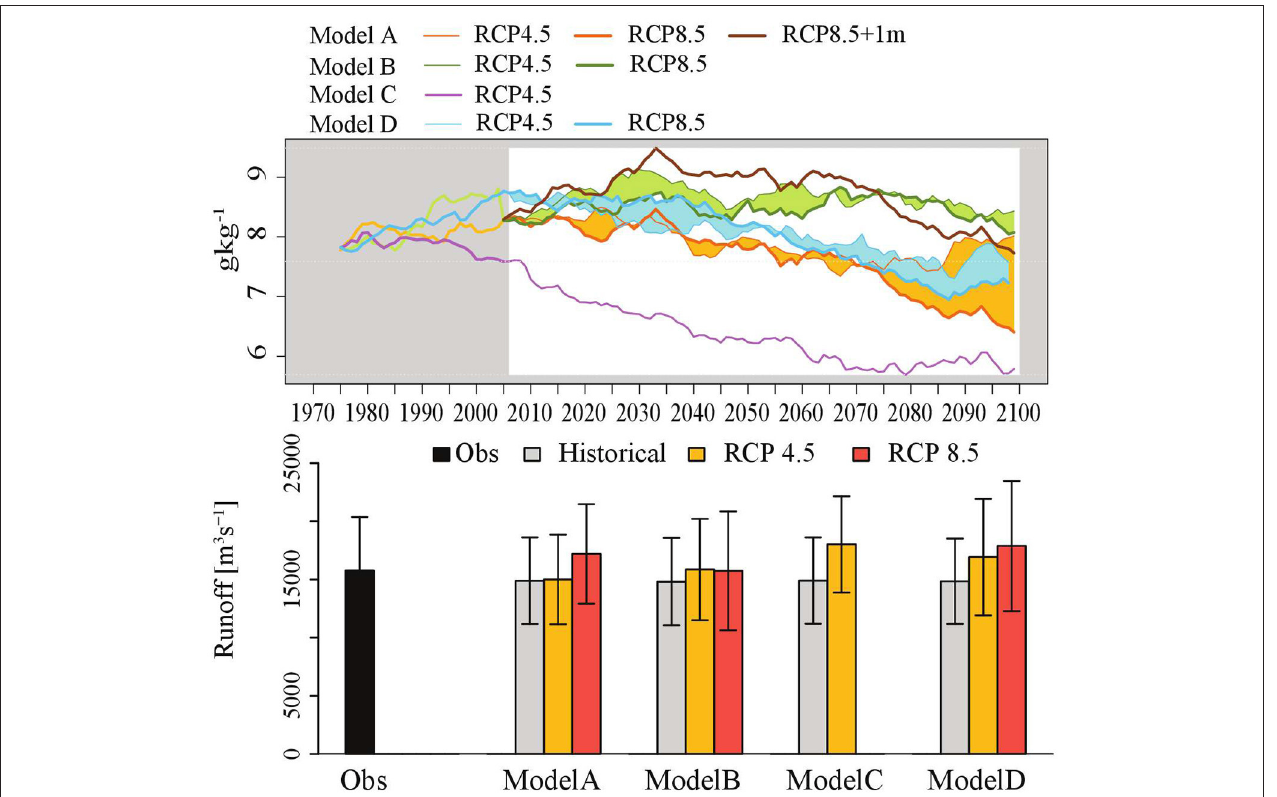
FIGURE 10 | Upper panel: Temporal evolution of volume averaged salinity (in g kg − 1 ) in the entire Baltic Sea during 1975–2098 in various climate scenarios (RCP 4.5 and 8.5) using four global climate models: MPI-ESM-LR (Model A); EC-EARTH (Model B); IPSL-CM5A-MR (Model C); HadGEM2-ES (Model D). Note, a scenario simulation driven by Model C and RCP 8.5 does not exist. A sensitivity experiment forced by Model A under the RCP 8.5 scenario assuming a 1 m higher mean sea level is also shown. Lower panel: Annual mean river runoff (in m 3 s − 1 ) in the scenario simulations and observations